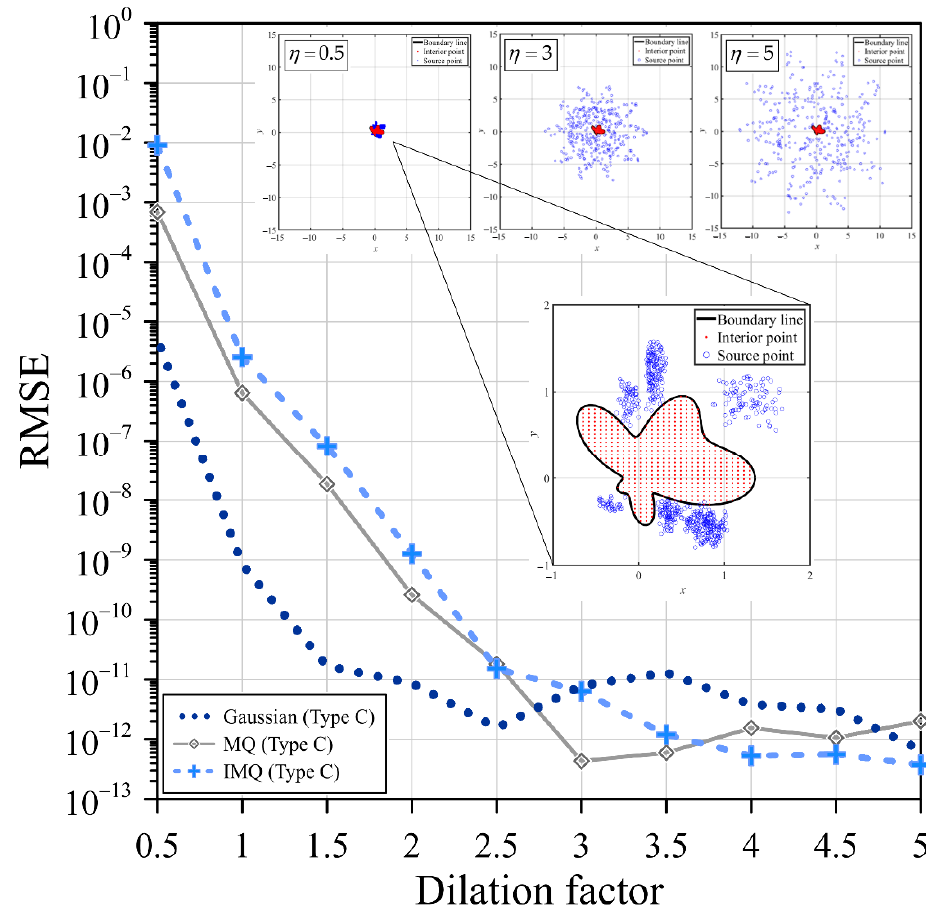
Figure 3. RMSE versus the dilation factor.